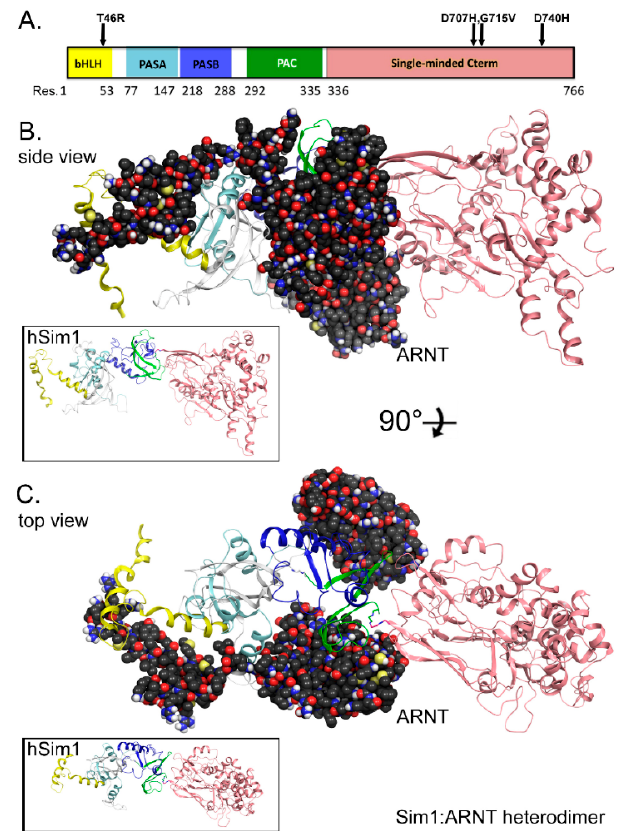
Figure 1. Generation of a composite hybrid (with mixed ab initio) model for full-length SIM1. ( A ) Domain legend for human SIM1. The domains are colored and key variants labeled above. ( B ) Dimeric model for the SIM1: ARNT structures. Full-length (766 aa) SIM1 is shown in ribbons colored as shown in the domain legend. ARNT structure is shown in van der Waals (VdW) spheres with carbon in dark-gray, oxygen-red, nitrogen-blue, and polar hydrogens-white. Inset is shown without ARNT in same orientation for reference. ( C ) Same dimeric SIM1: ARNT structure rotated 90° along the X-axis.